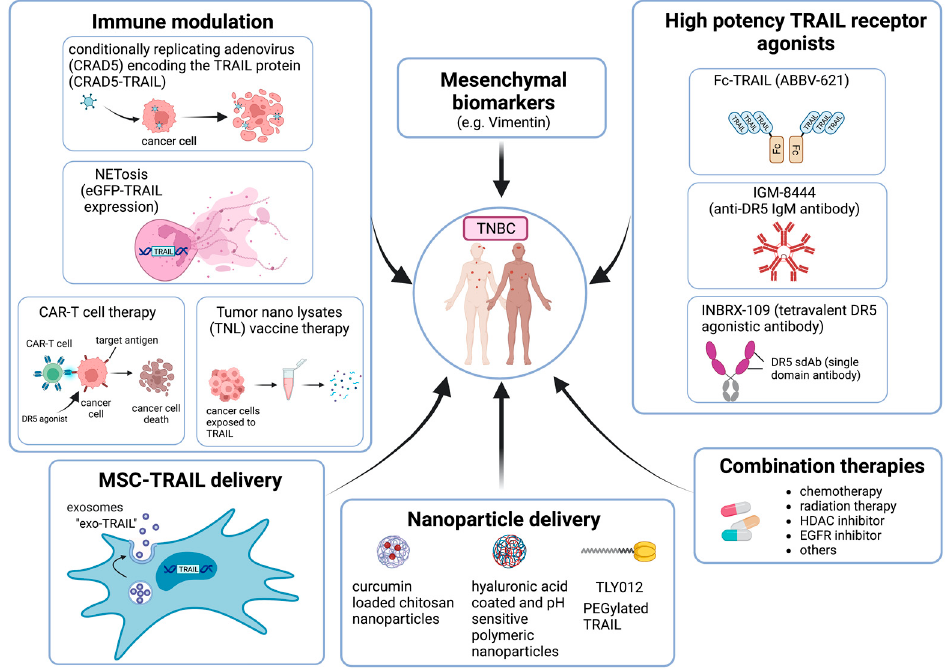
Figure 3. Plausible strategies to improve TRAIL efficacy in TNBC. Predictive biomarkers like Vi- mentin, high-potency TRAIL receptor agonists such as multivalent anti-TRAIL receptors antibody, different combinatorial therapies including chemotherapy, radiation therapy, HDAC inhibitors, EGFR inhibitors, different forms of nanostructures delivery system, MSC TRAIL delivery via exosome and along with possible immune therapies may enhance future TRAIL therapy in TNBC. Though to date, specific immune modulatory therapy has not yet been reported but there remains a scope to have the above illustrated immune modulatory delivery system to enter future clinical trials for TNBC. Figure was created with BioRender.com (accessed on 8 November